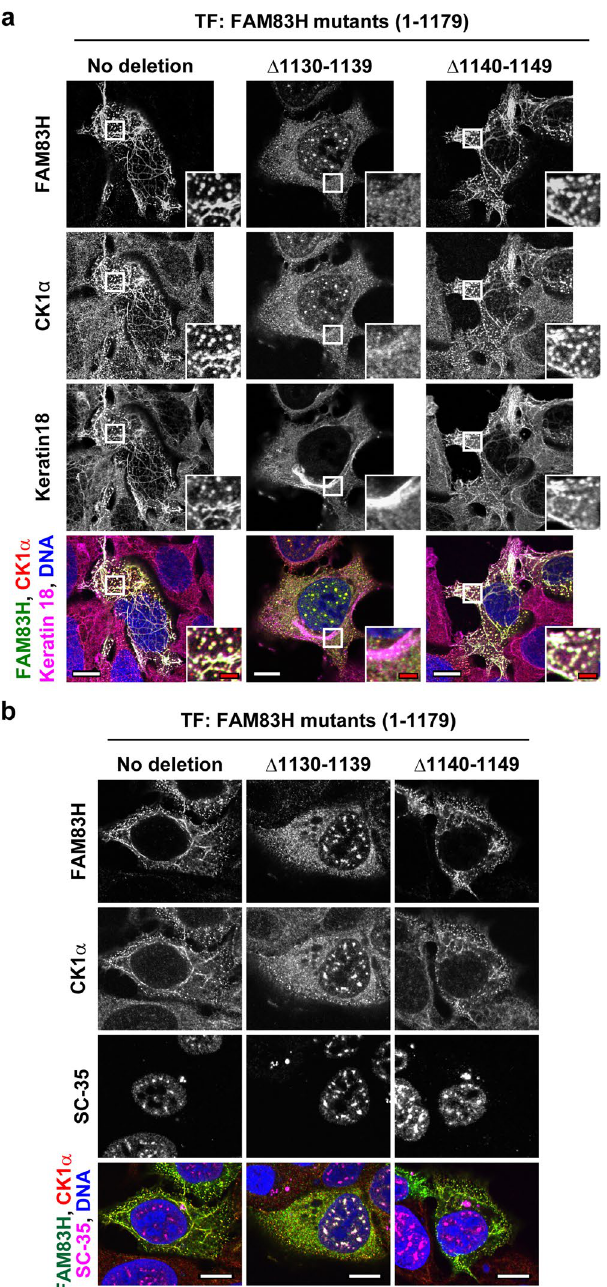
Figure 5. Deletion of 10 amino acid residues 1130–1139 of FAM83H is sufficient for its translocation from the keratin cytoskeleton to the nuclear speckles. DLD1 cells were transfected with the plasmids encoding the indicated FAM83H mutants and were analyzed via immunofluorescence using antibodies for ( a ) FAM83H (green), CK1α (red), and keratin 18 (magenta) or ( b ) FAM83H (green), CK1α (red), and SC-35 (magenta). Nuclei were visualized by DAPI (blue). ( a ) Magnified images at the regions enclosed by white squares are shown. White and red bars indicate 10 and 2 μm,